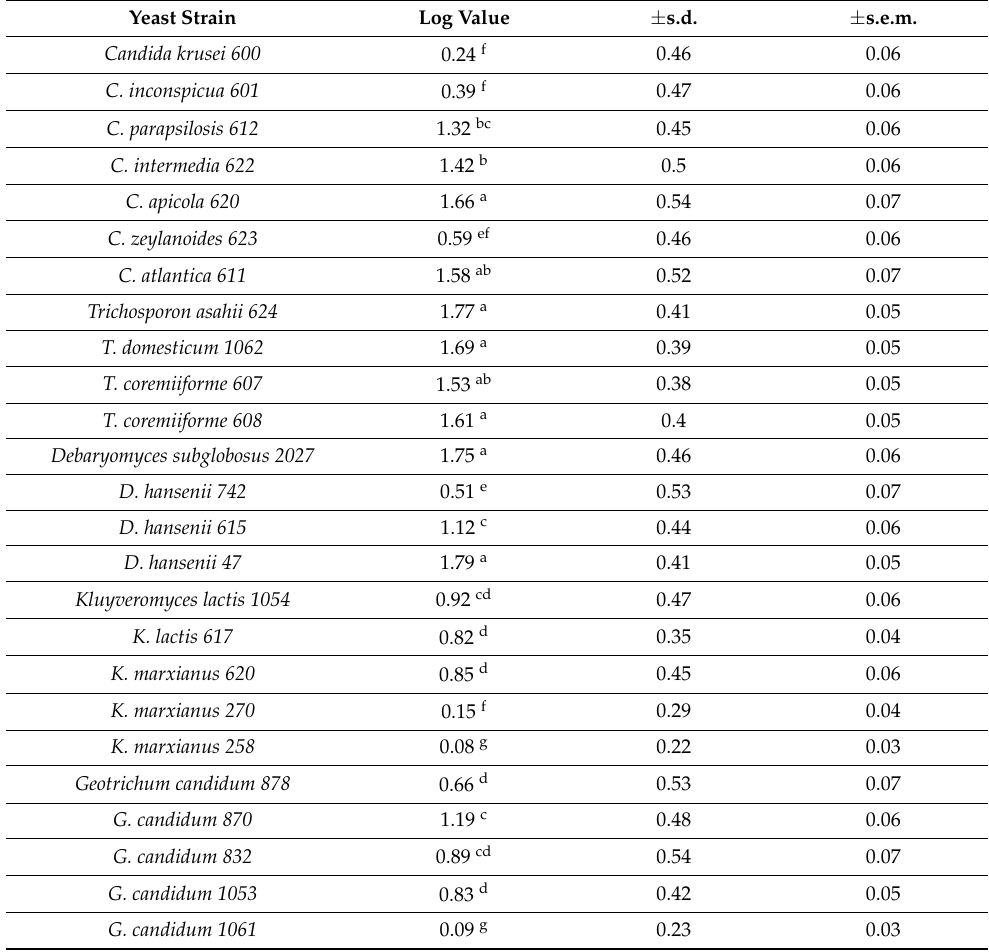
Table A4. The variability in sensitivity 25 yeast strains to all strains of L. plantarum . The data represents logarithmically transformed index scale values, s.d. and s.e.m. F (24, 1050) = 400.009; p ≤ 0.00 E ≤ 0.05. (Factorial ANOVA, Statistica v. 12. Post Hoc Tukey’s HSD Test). The index letter indicates significant differences. Significant at α ≤